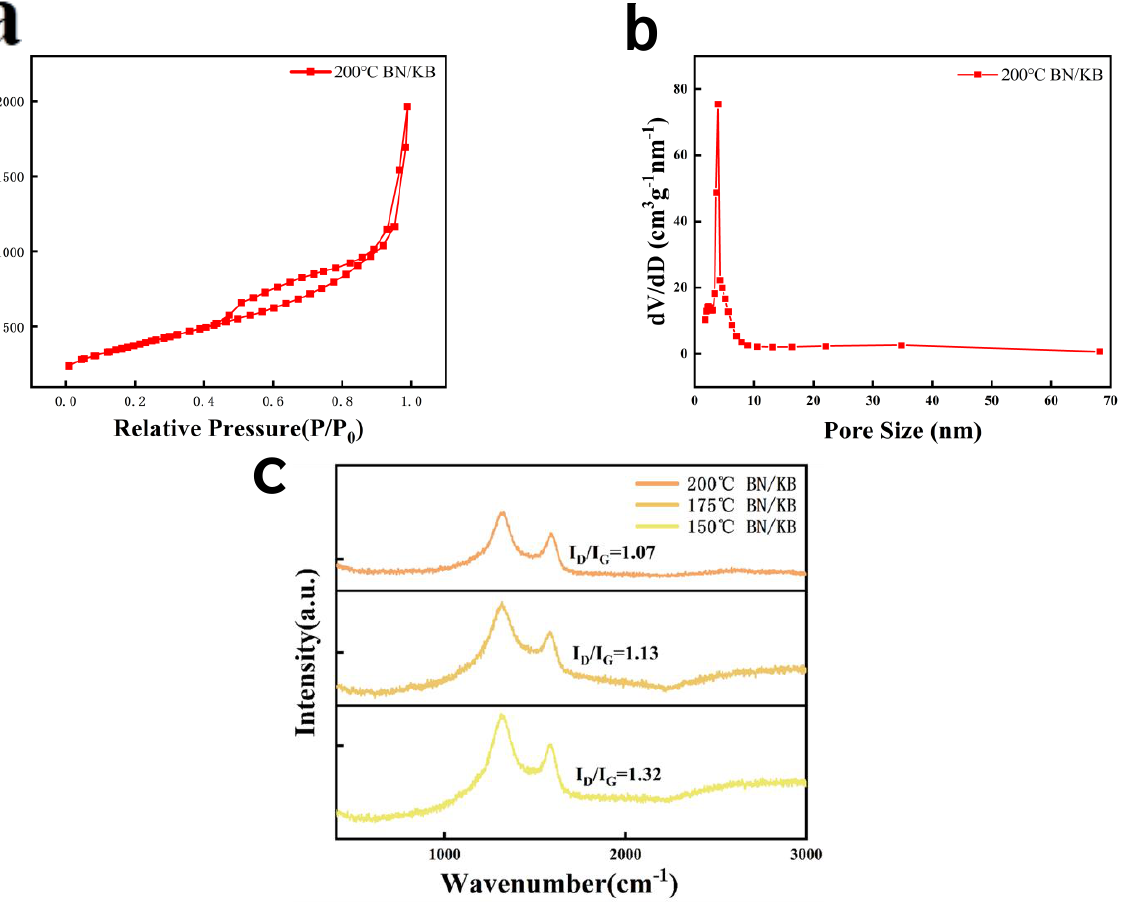
Figure 3. Specific surface area ( a ) and pore-size distribution ( b ) of BN/KB. ( c ) Raman spectrum of BN/KB material at 200 °C, 175 °C, and 150 °C.